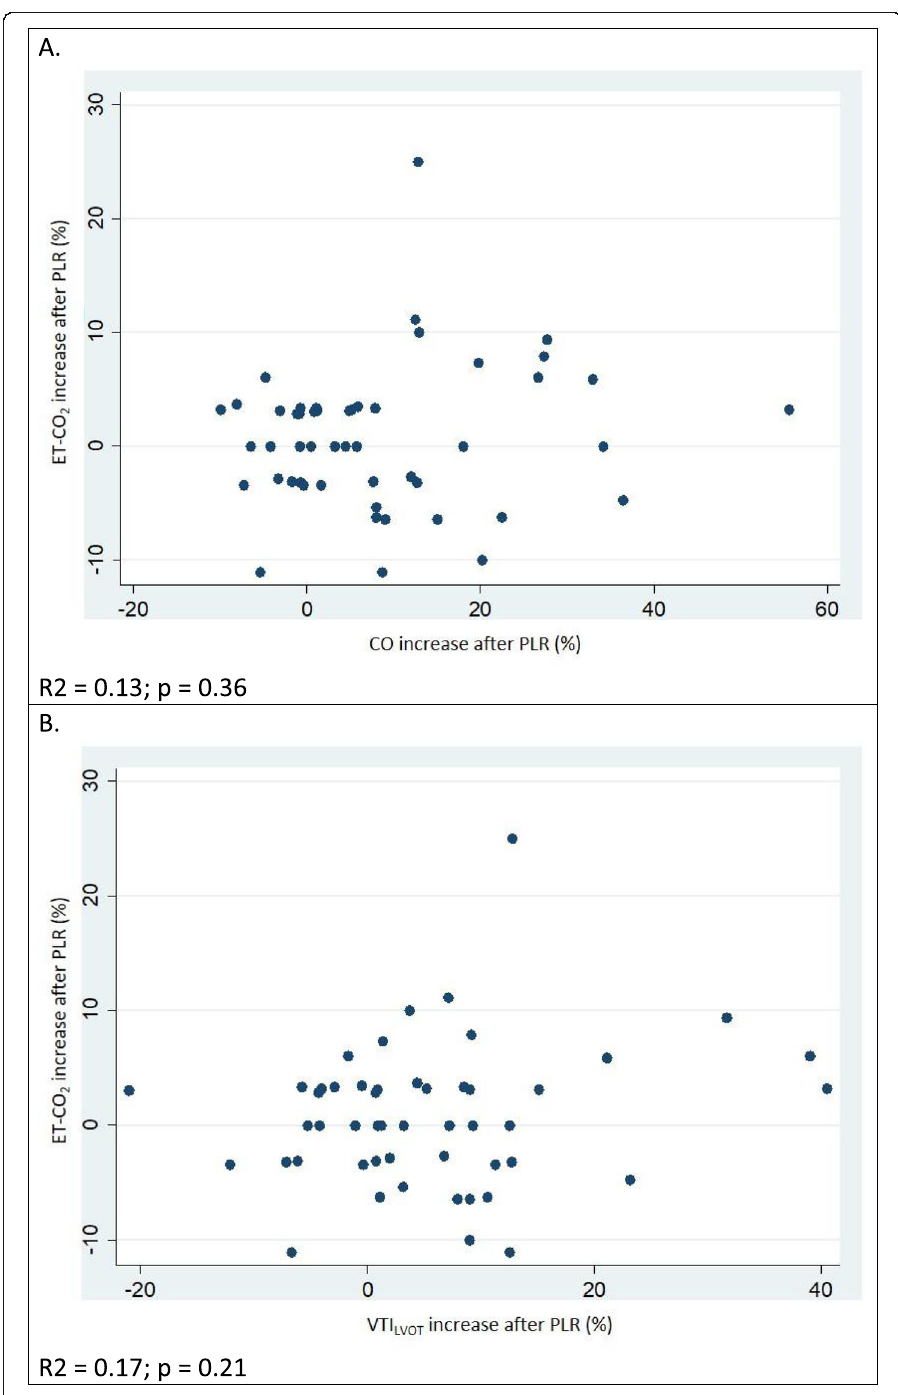
Fig. 4 Correlation between PLR-induced changes in ET-CO 2 and a CO and b VTI LVOT . ET-CO2, end-tidal carbon dioxide; VTI LVOT , left ventricle outflow tract velocity time integral; CO, cardiac